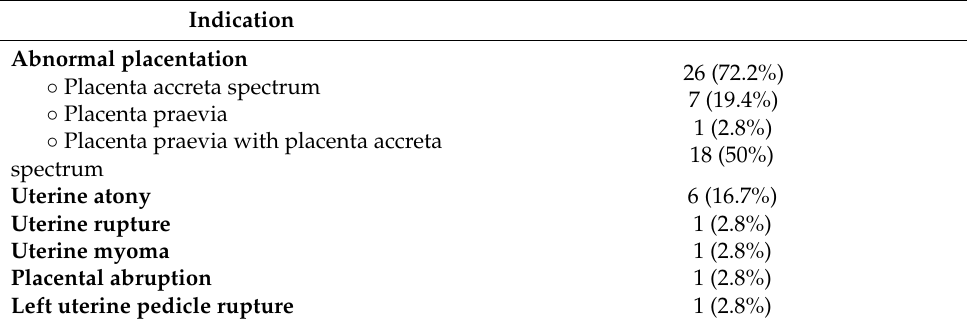
Table 2. Indications for emergency peripartum hysterectomy in the 36 patients.